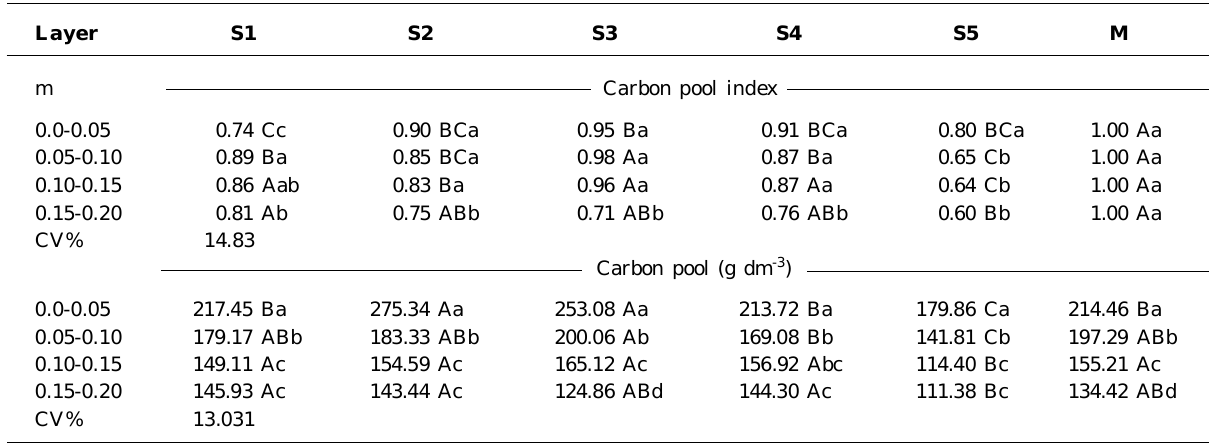
Means followed by same capital letters in he row and lowercase letters in the column did not differ from each other by the Tukey test at 5 %.